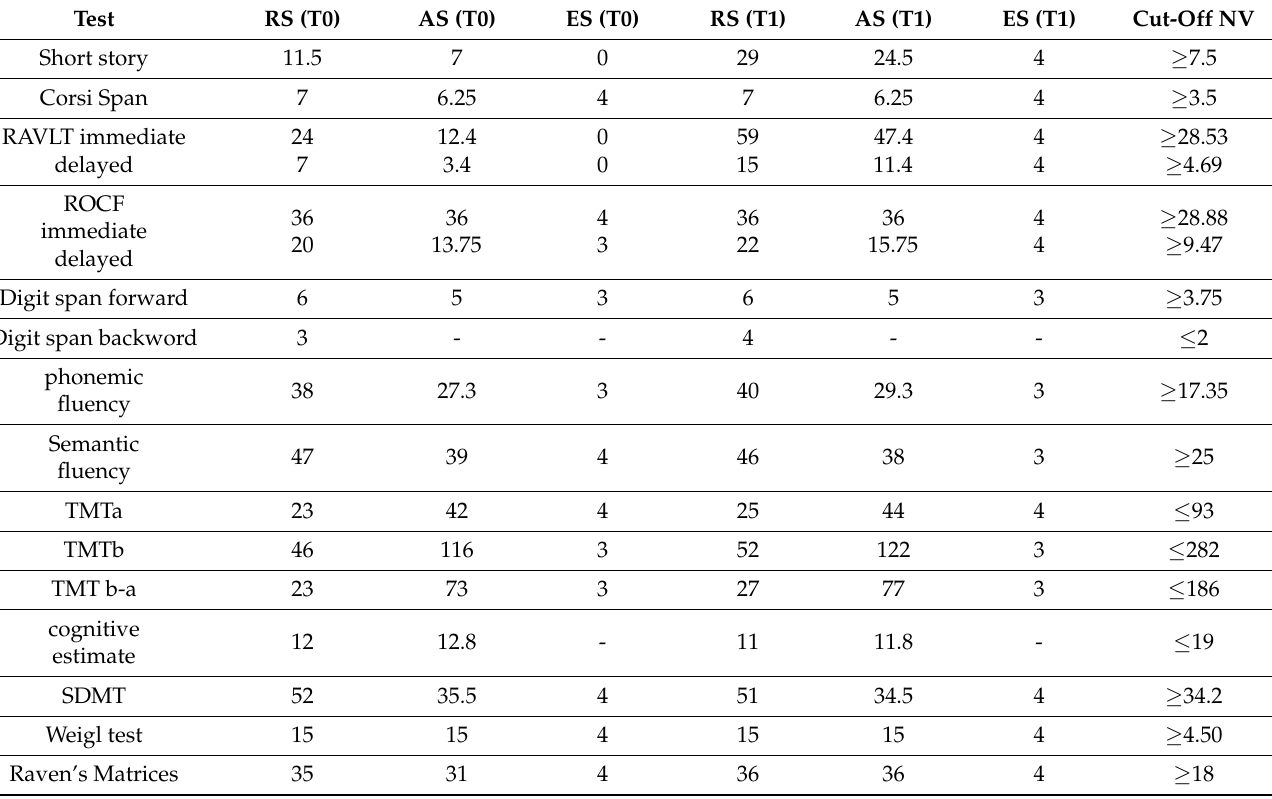
Table 1. Neuropsychological examinations: baseline (T0) and follow-up (T1).